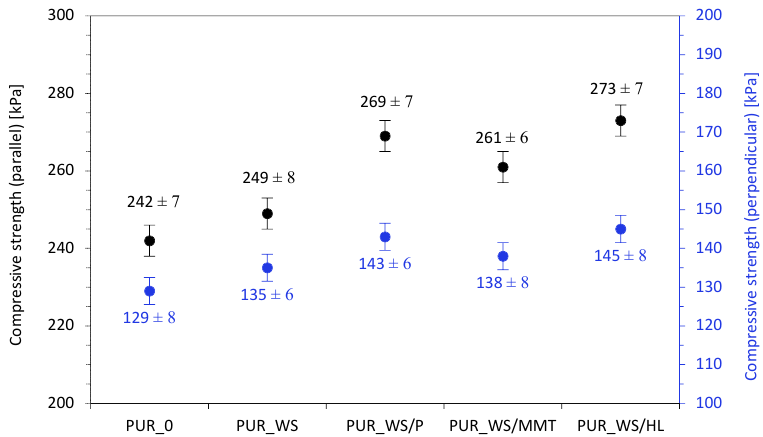
Figure 7. The results of apparent density and cell size of PUR composites containing walnut shell fillers.